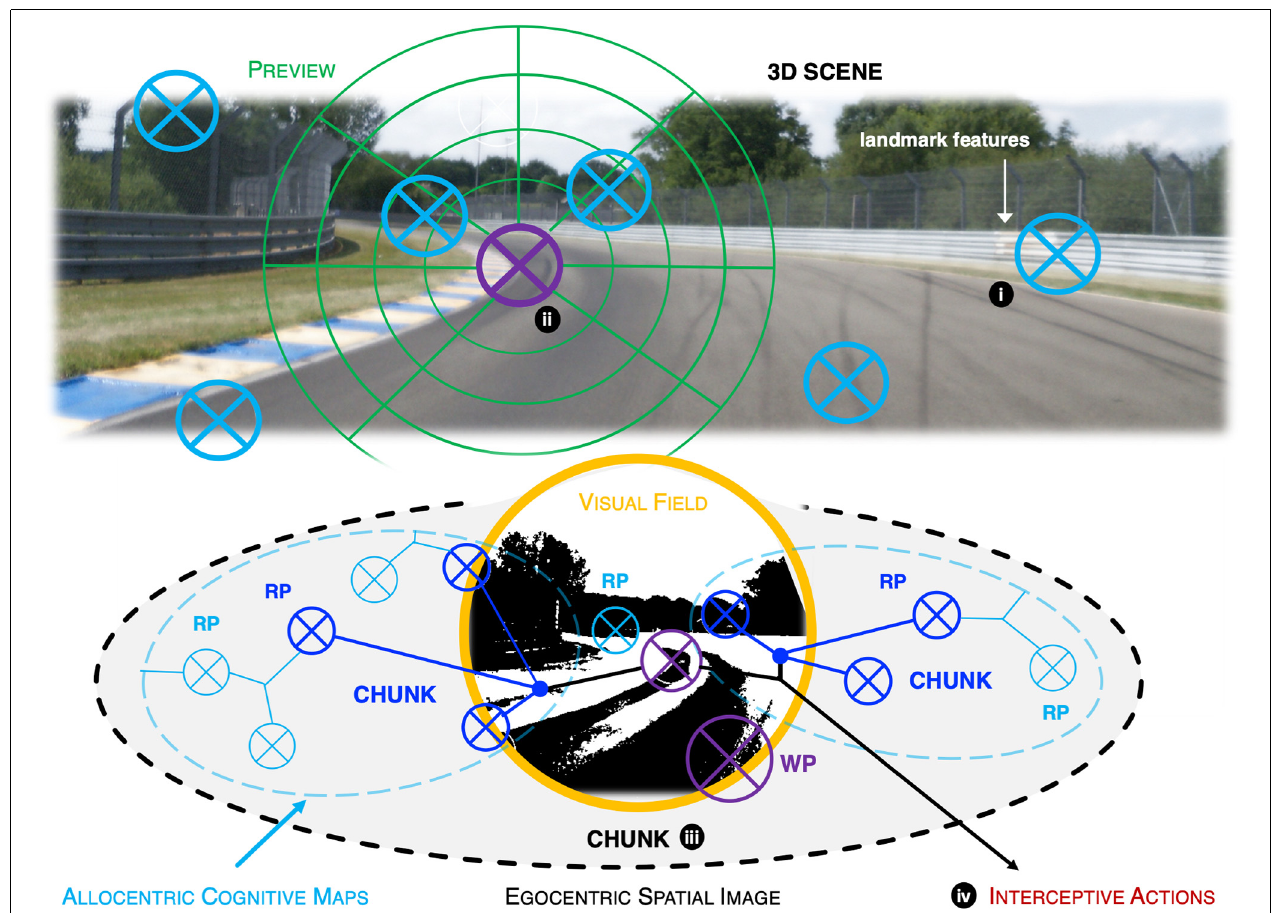
FIGURE 5 | Schematic illustration of egocentric chunking of reference points and waypoints. (i) Reference points in the 3D scene are fixed objects or locations, recognized by landmark visual features. They function as landmarks for localization in the large-scale environment. RP information is stored into/recalled from spatial long-term memory that encodes their allocentric arrangement (cognitive maps). (ii) Waypoint locations on the path. They are identified in visual preview as targets of gaze or in peripheral vision. WP information is used to guide and sequence interceptive actions. (iii) RPs and WPs are chunked into relational patterns in the egocentric visual field/spatial image. (iv) Waypoints are targets of interceptive visual guidance, and timing cues for control actions at the waypoint. RPs allow the observer to localize themselves on the map; they are associated with WPs in the chunking process. Note that waypoints are not stored in allocentric memory, they are represented in egocentric space (relative to the observer). Waypoint locations are fixed locations in 3D space, but there need not be any reference point exactly at the waypoint; their location is based on the surrounding scene (reference points including but not limited to the current field of view), visual preview, and also current motor plans and goals. They are more flexible and dynamic than reference points, being associated with, and adjusted on the basis of, bottom-up feedback (For example, unlike reference points, the waypoint can be in different places on successive runs through the same bend as it is taken at a different speed, grip level, etc.). An action happening at the waypoint allows operationalization of the concept, even if there is no stimulus object or visual feature at that spot. Note that for illustration only a few RPs per chunk and only a few chunks are sketched out. In reality, the number of RPs per chunk is probably large—as is the number of